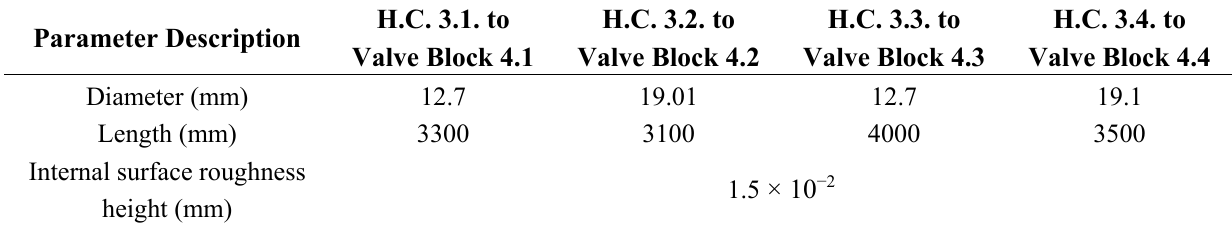
Table 5. Hydraulic pipeline